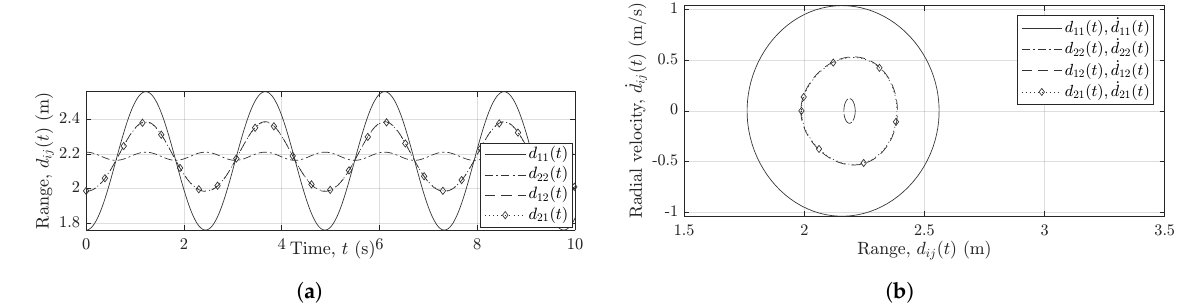
Figure 8. ( a ) The analytical radial range components d ij ( t ) and ( b ) the analytical radial velocity components ˙ d ij ( t ) for ( L T x ) = ( L T x ) . , L R x , L R x 2 2 1 1